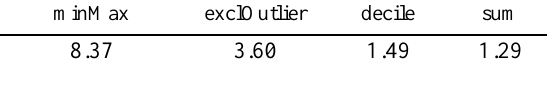
Figure 10. Matching results: Multiple best cells vs. one single best cell Table 2. Number of cells with highest score Average number of cells achieving the highest